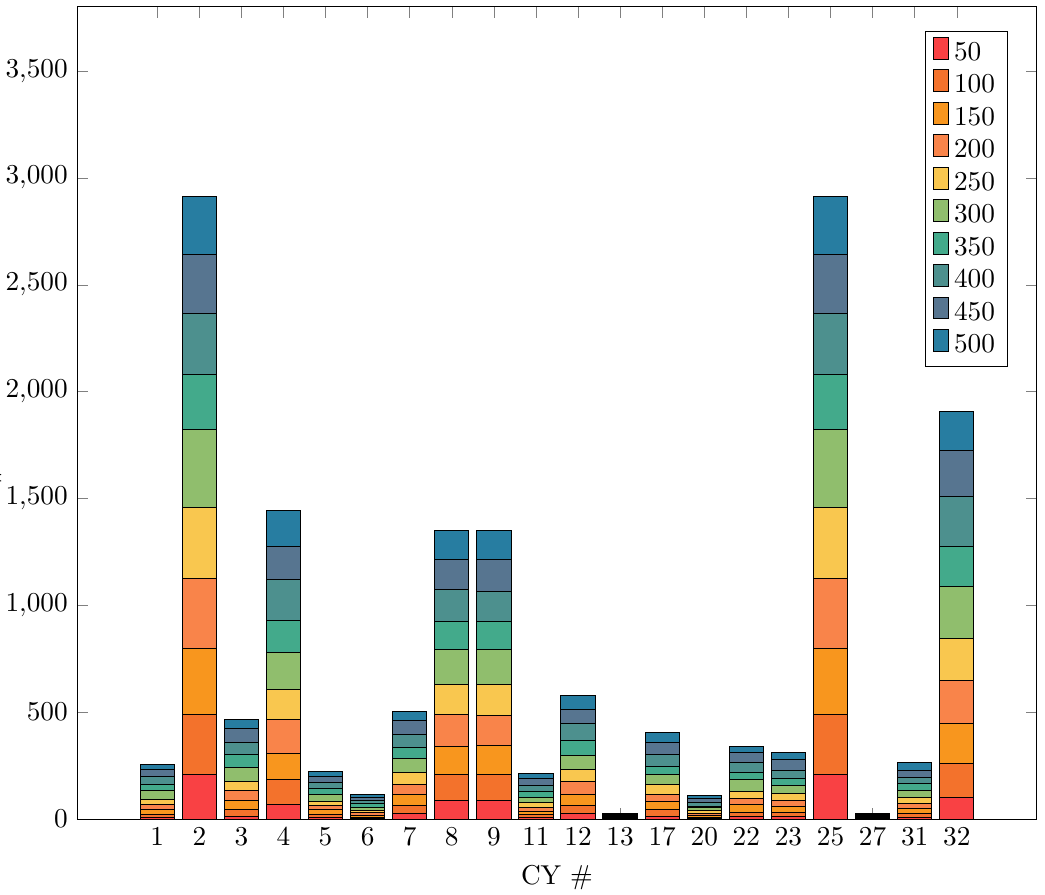
Figure 2. Statistics of PFFV for non K3-fibered CYs. Here different colors presenting the PFFV numbers for each of the CY space correspond to N